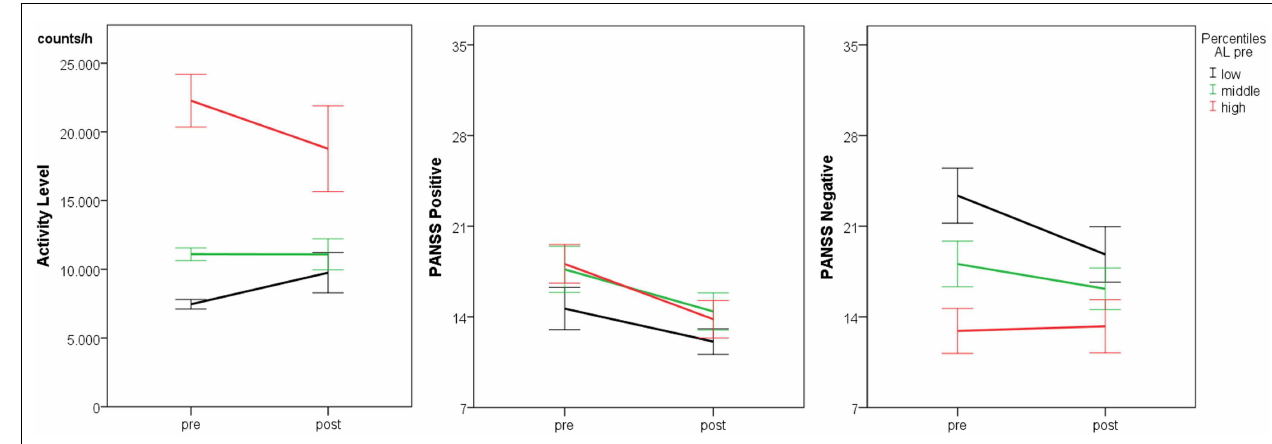
FIGURE 1 |Within-episode course of activity and psychopathology ( n = 45) lines indicate mean ± SE .